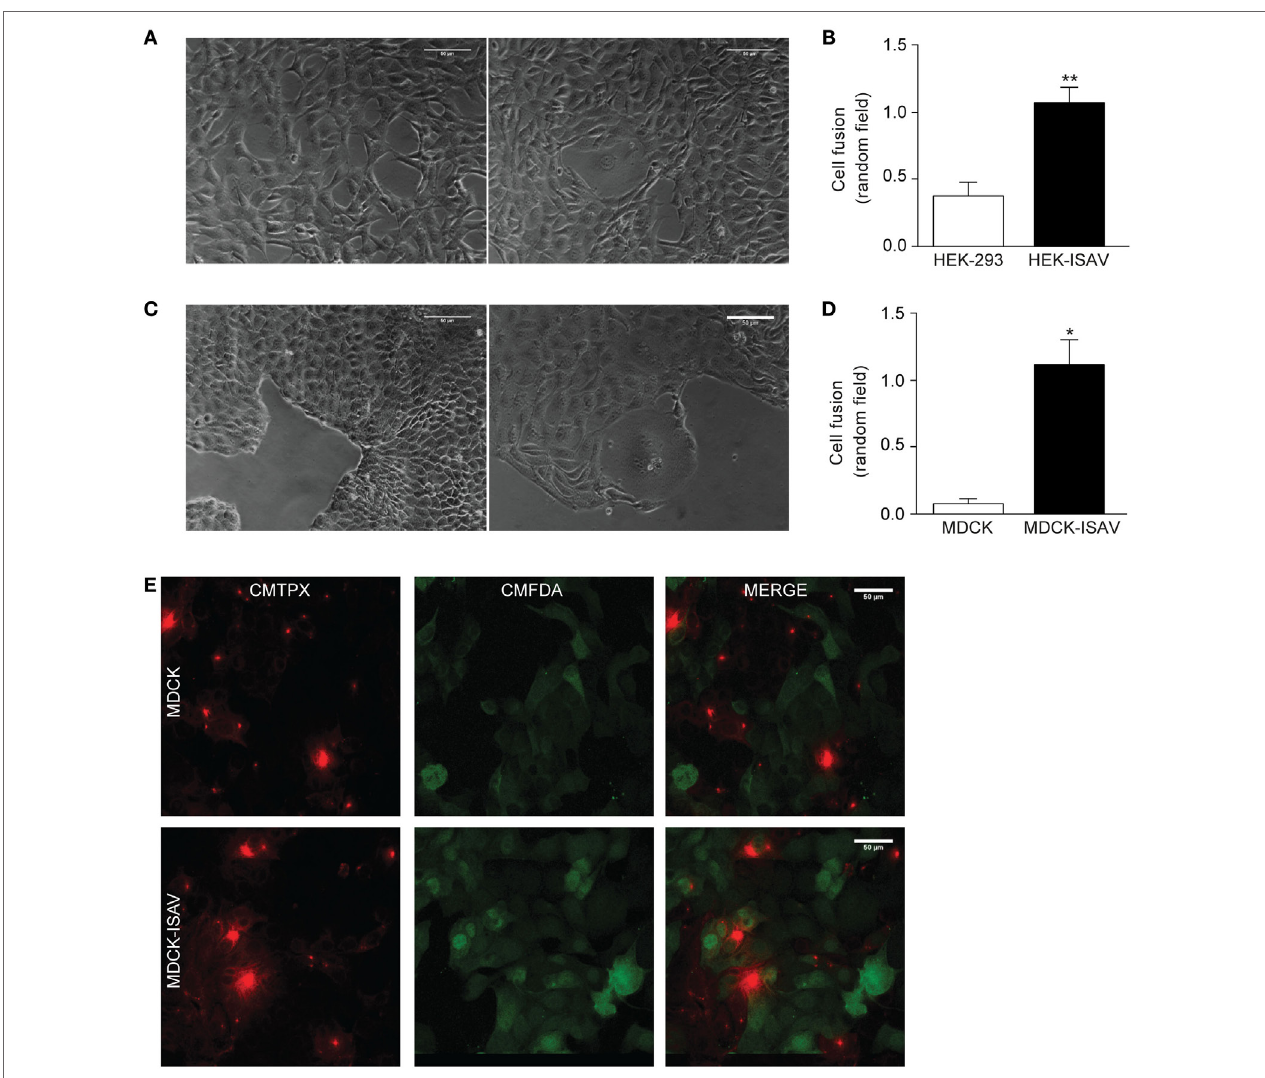
FigUre 1 | Fusion protein infectious salmon anemia virus (ISAV) induces fusion in HEK293 and MDCK cells. (a) Light microscope images of cell fusion in non-transfected (left) or ISAV-transfected HEK293 cells (right), (B) quantification of cell fusion of 10 random fields in non-transfected or ISAV-transfected HEK293 cells ( n = 5). ( c) Light microscope images of cell fusion in non-transfected (left) or ISAV-transfected MDCK cells (right). (D) Quantification of cell fusion of 10 random fields in non-transfected or ISAV-transfected MDCK cells ( n = 5). (e) MDCK cells were labeled with CMFDA or CMTPX separately, and then they were mixed and grown for 24 h. The upper panel shows non-transfected MDCK and the lower panel shows ISAV-transfected MDCK. Statistical analyses were performed using the Mann–Whitney test (* p < 0.05, ** p < 0.01).